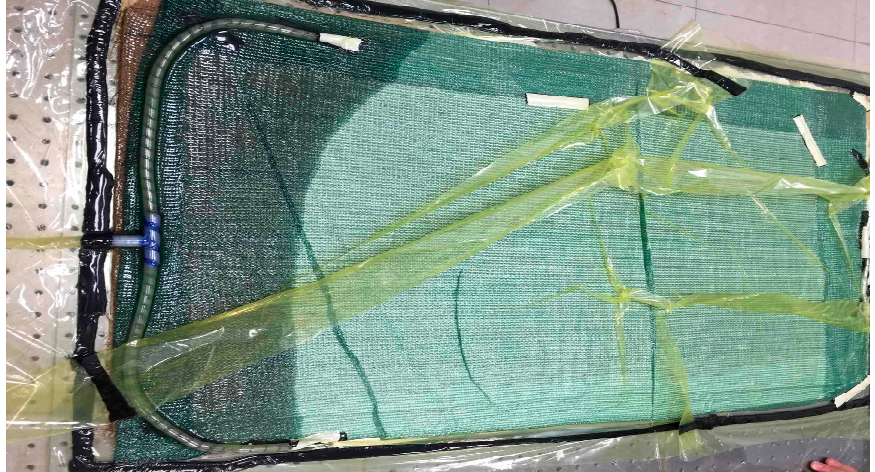
Figure 1. VARI processing adopted to manufacture SMA/GF/epoxy hybrid composite laminates.